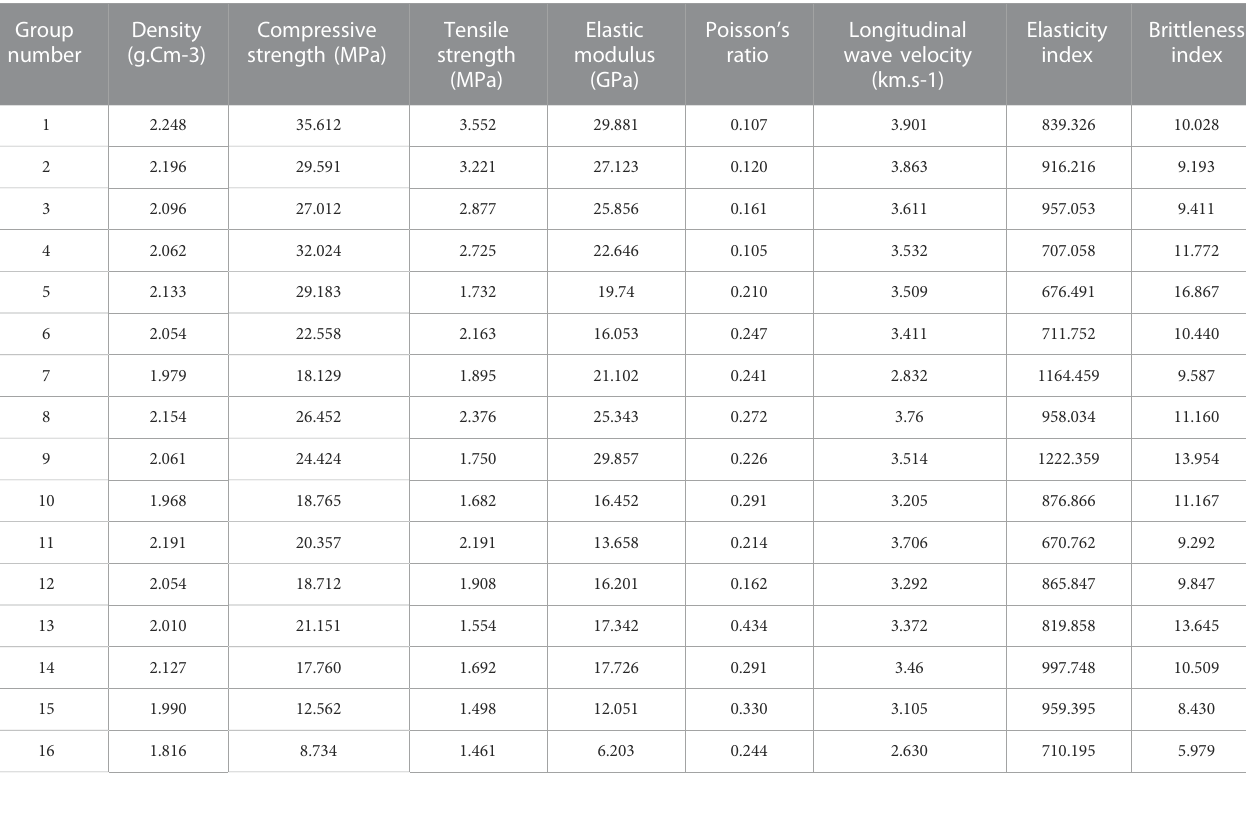
TABLE 3 Measurement results of physical and mechanical parameters.